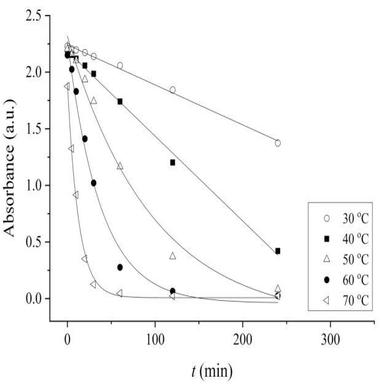
Decolorization of tartrazine solution monitored at λmax = 426 nm, and at different temperatures, during reaction time.